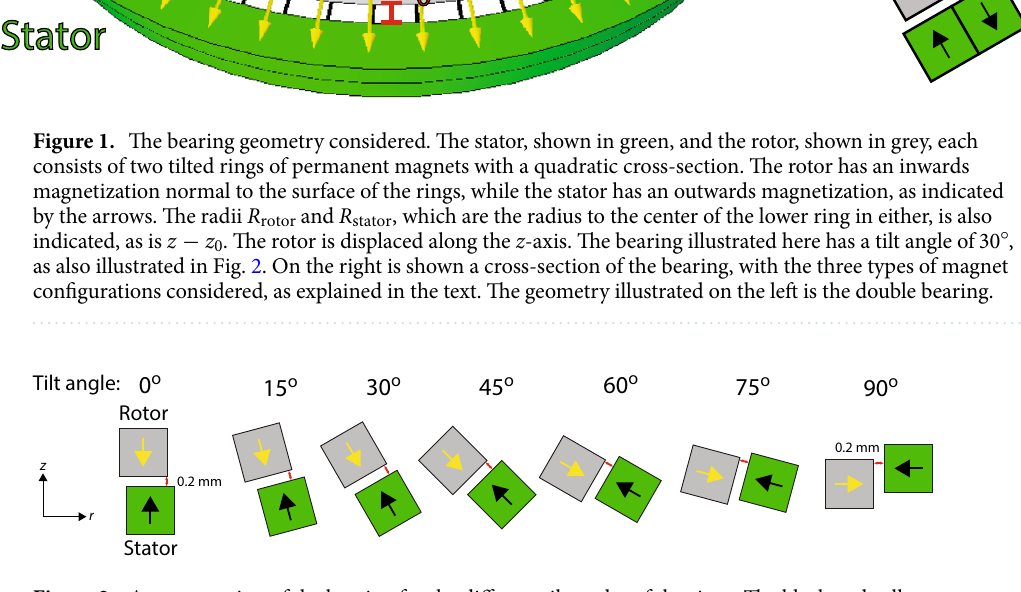
Figure 2. A cross-section of the bearing for the different tilt angles of the rings. The black and yellow arrows indicated the direction of magnetization of the rotor and stator, respectively. Shown as a red line is the minimum distance between the rotor and the stator in each configuration, which is always 0.2